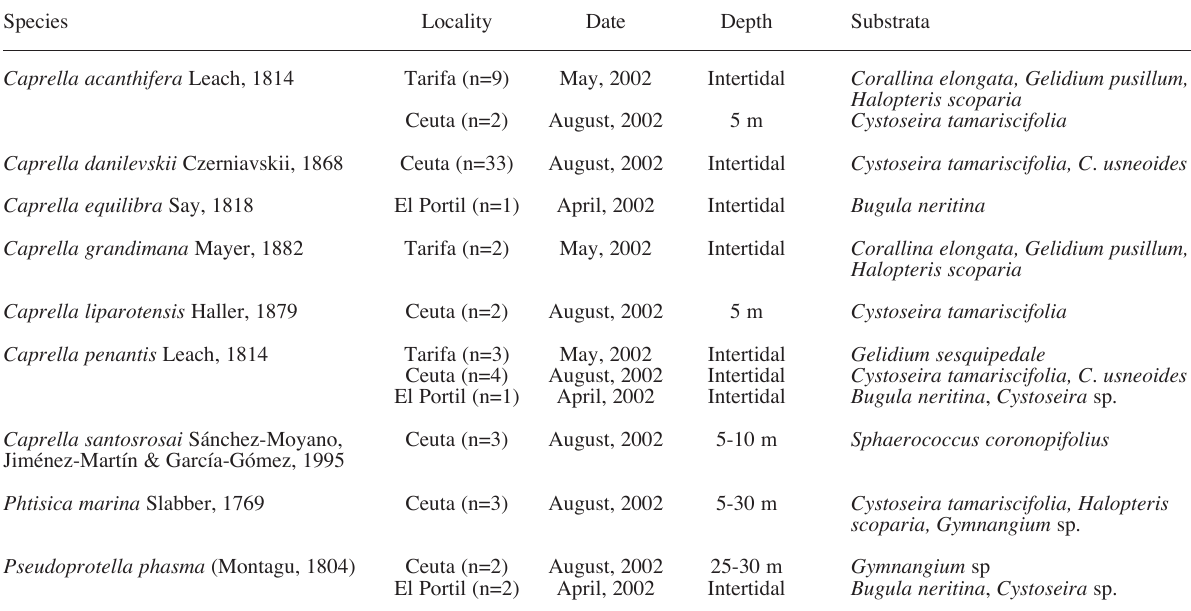
Table 1. Caprellids from the Strait of Gibraltar used for the study. Details of locality, data, depth and substrata are given. [n=number of samples; each sample contains a number of specimens enough for chemical analysis (25-30 mg)]